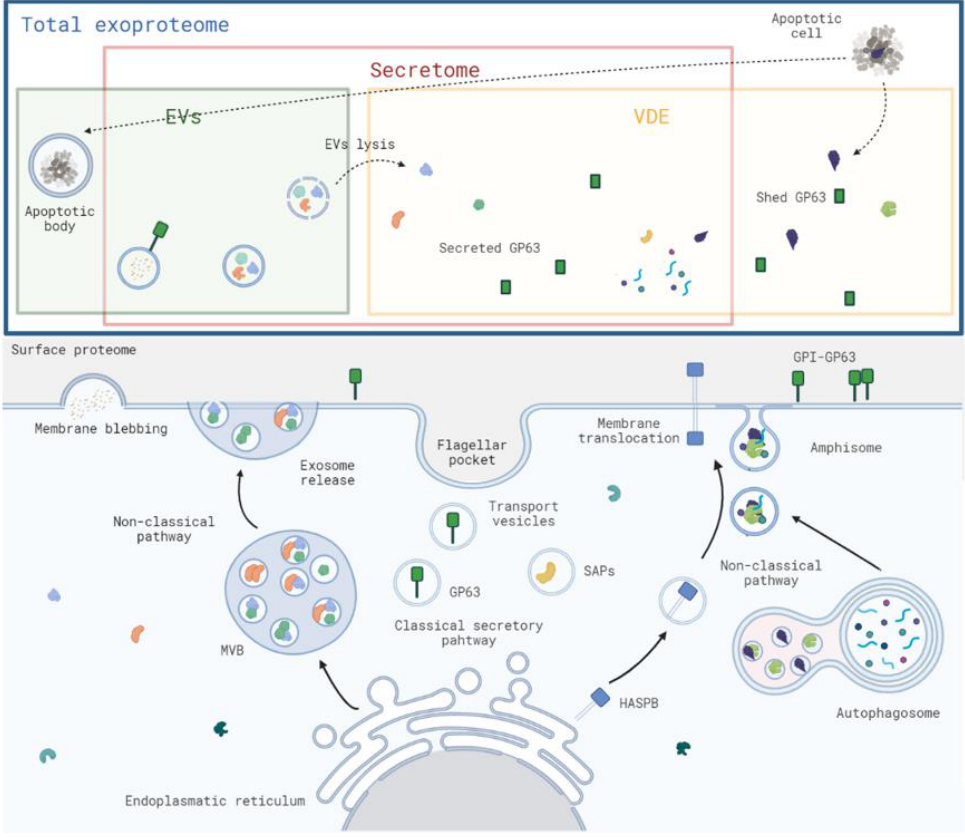
Figure 1. Schematic representation of the Leishmania spp. total exoproteome, secretome, extracellular vesicles (EVs), and vesicle depleted exoproteome (VDE) concepts. The exoproteome (blue rectangle) regroups all the secreted proteins as well as proteins that originated in the shedding of surface proteins or cell lysis; the secretome (pink rectangle) regroups all secreted proteins through conventional like the secreted acid phosphatases (SAPs) or non-classical pathways like the hydrophilic acylated surface protein B (HASPB); the EV fraction (green shaded rectangle) contains all vesicular components of the exoproteome, including those that originate from secretion, like the exosomes that are accumulated and released from the multivesicular bodies (MVBs) or from cellular lysis (dotted arrows); and the VDE (yellow shaded rectangle) contains all the non-vesicular components of the VDE, including those that originate from secretion, shedding from the surface, or lysis of cells or EVs (dotted arrows). The figure was created with BioRender.com.